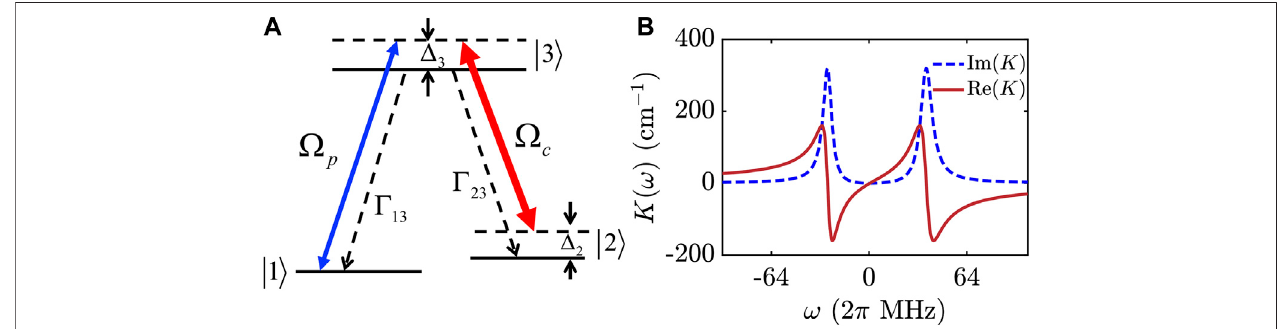
FIGURE 1 | (A) Energy-level diagram and excitation scheme of the Λ -shaped three-level atomic system for realizing EIT. The probe fi eld (with center angular frequency ω p and half Rabi frequency Ω p ) couples the atomic levels | 1 〉 and | 3 〉 ; the CW control fi eld (with angular frequency ω c and half Rabi frequency Ω c ) couples the atomic levels | 2 〉 and | 3 〉 ; Γ 13 ( Γ 23 ) is the decay rate from | 3 〉 to | 1 〉 ( | 3 〉 to | 2 〉 ); Δ 3 ( Δ 2 ) is one-photon (two-photon) detuning. (B) The imaginary part Im ( K ) and real part Re ( K ) of the linear dispersion relation K as a function of ω ( ω (cid:2) 0 corresponds to the central frequency of the probe pulse).